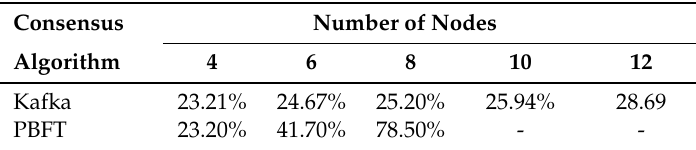
Table 4. Memory ratio of Kafka and PBFT.